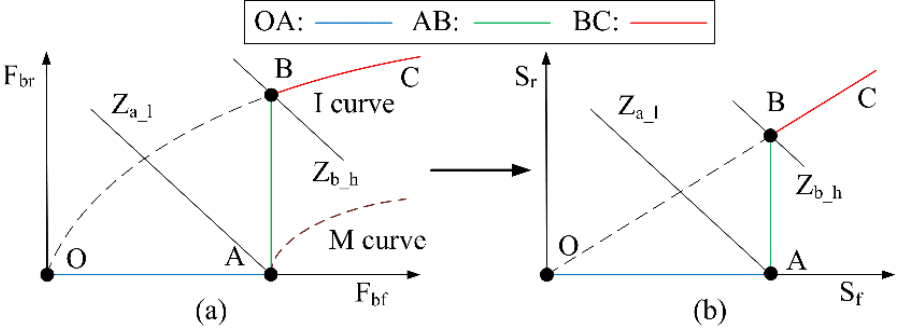
Figure 3. Coordinate system conversion: ( a ) wheel braking force distribution and ( b ) slip ratio distribution.